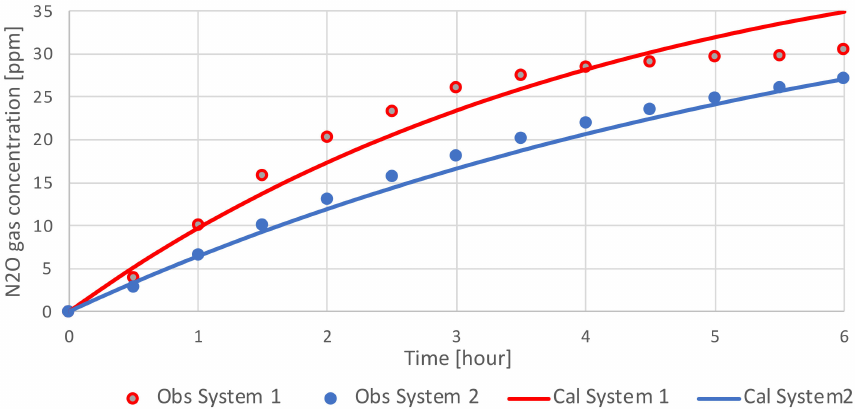
Figure 5. Temporal variations in measured and calculated N 2 O gas concentrations in the silicone tubes of systems 1 and